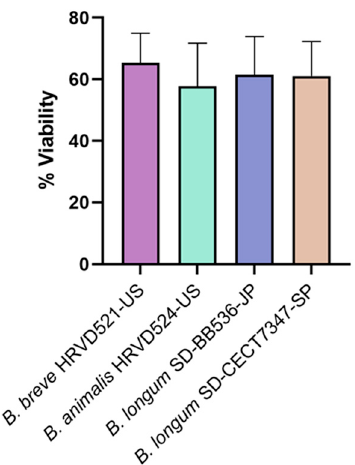
Figure 1. Percent viability of lyophilized bifidobacteria. The CFU of the cultures before freeze-drying was compared to the CFU of the lyophilized bacterial powder ( n = 4).